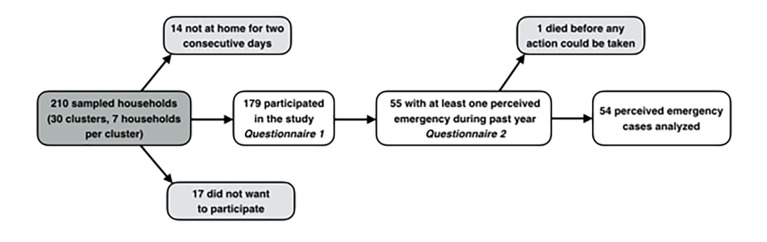
Sampled households, reasons for non-participation, and households interviewed with questionnaire 1 and 2.